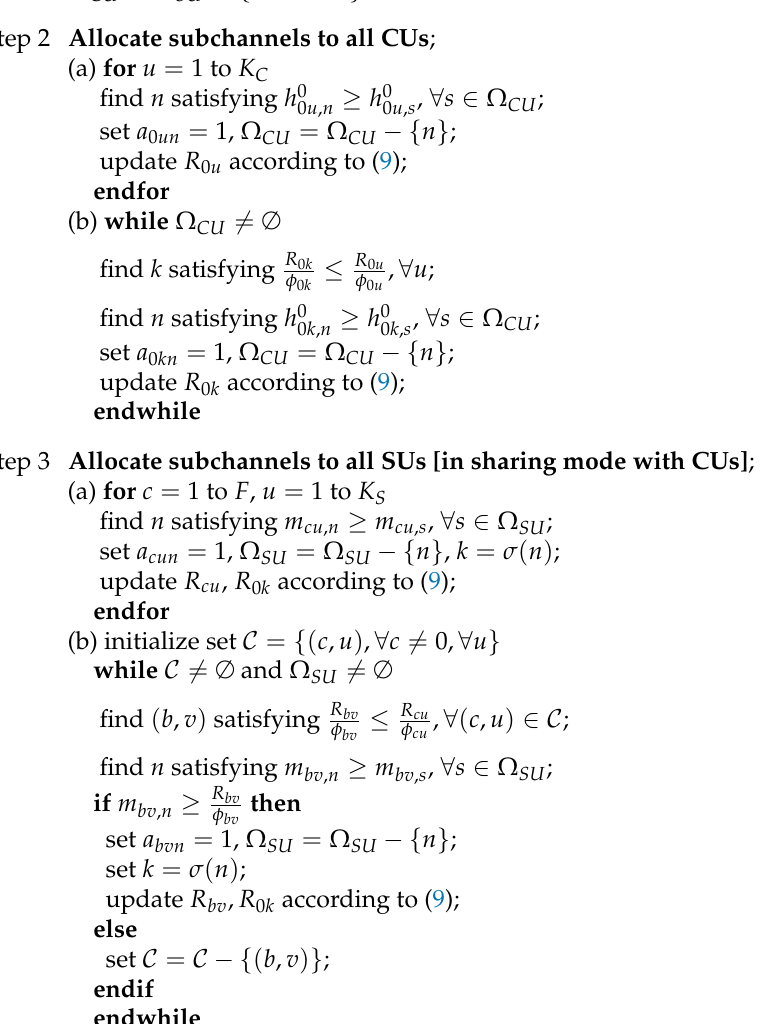
Algorithm 1 Subchannel allocation